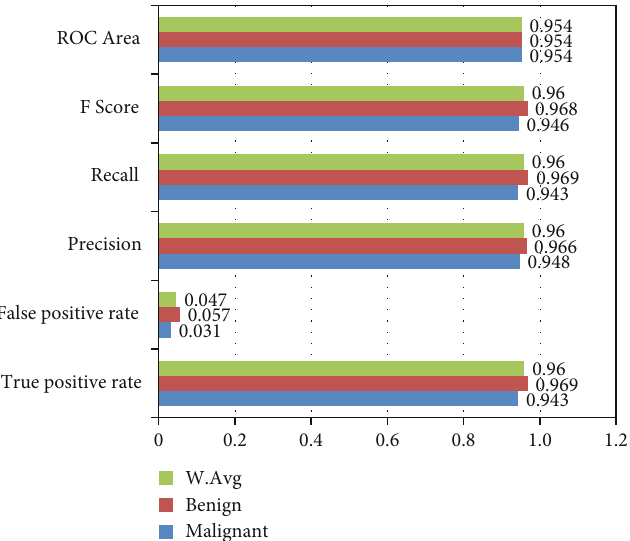
Figure 12: Accuracy and sensitivity information of the KNN technique.